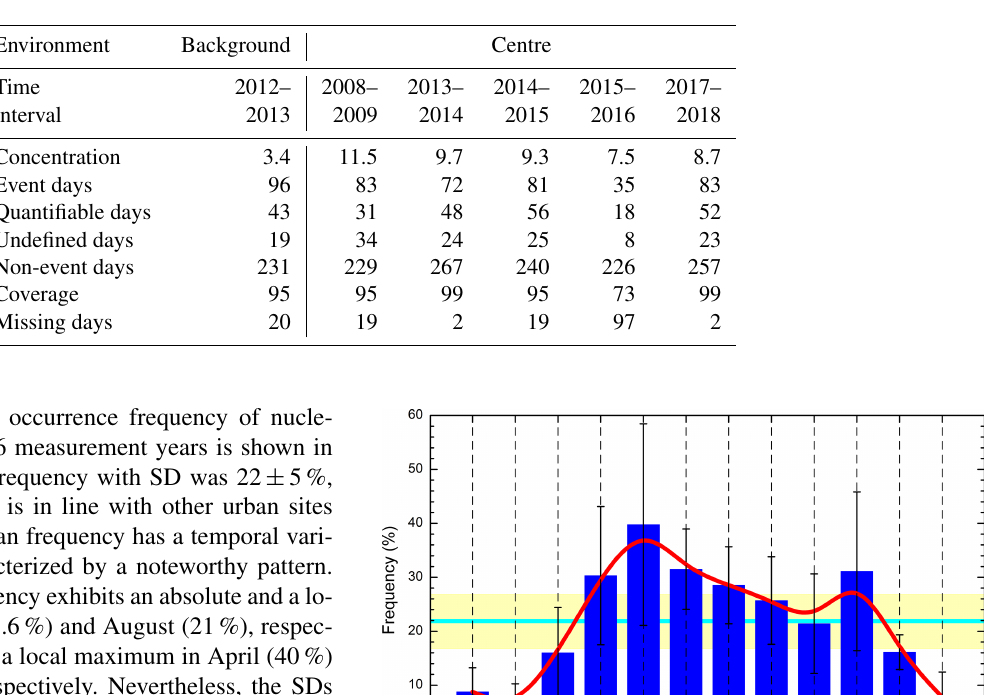
Table 1. Annual median total particle number concentrations (in 10 3 cm − 3 ), number of days with NPF and growth events, quantifiable event days, non-event days, undefined days, missing days and the coverage (in %) of relevant days in the near-city background and city centre separately for the 1-year-long measurement time intervals.